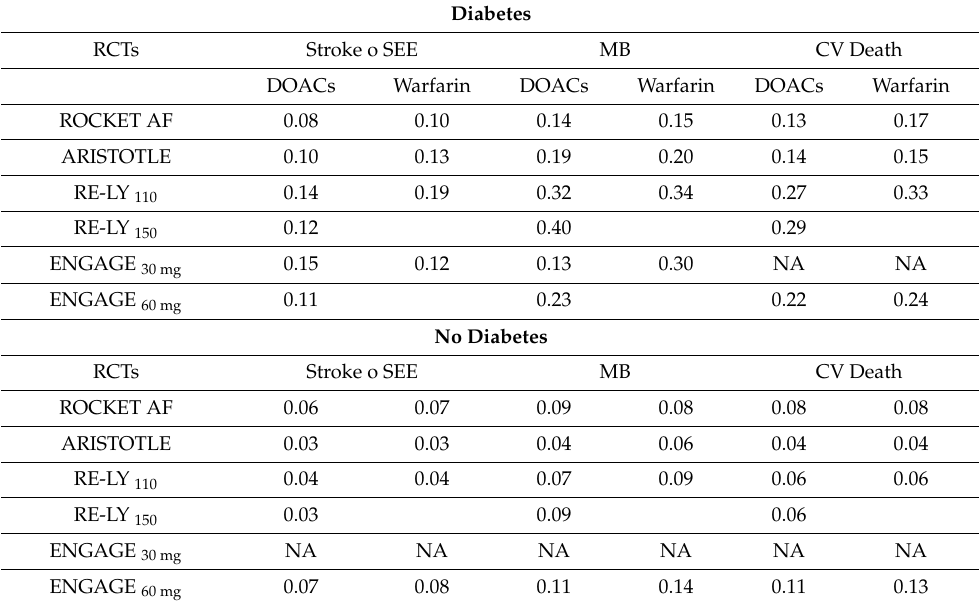
Table 5. Risk index of stroke/systemic embolism, major bleeding, and cardiovascular death in patients with and without diabetes in the pivotal